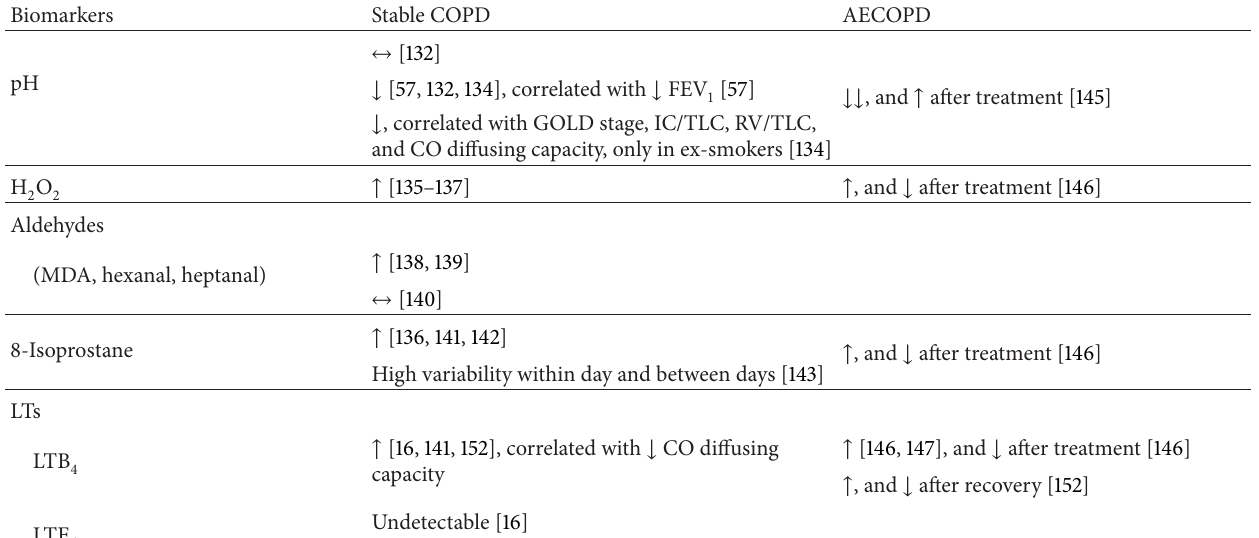
Table 3: Changes of EBC biomarkers in chronic obstructive pulmonary disease